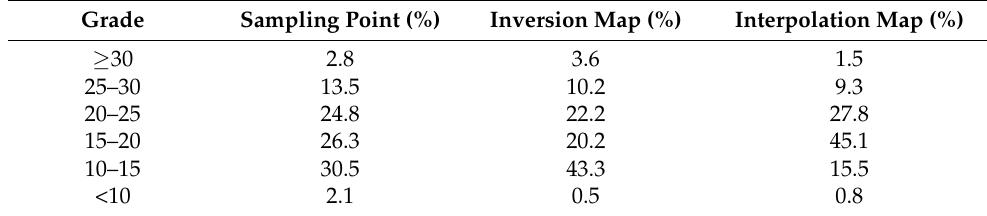
Figure 5. Interpolation analysis of soil organic matter in southwest Shandong Province. Table 2. Comparison of sample data, interpolation results, and inversion results. Table 2. Comparison of sample data, interpolation results, and inversion